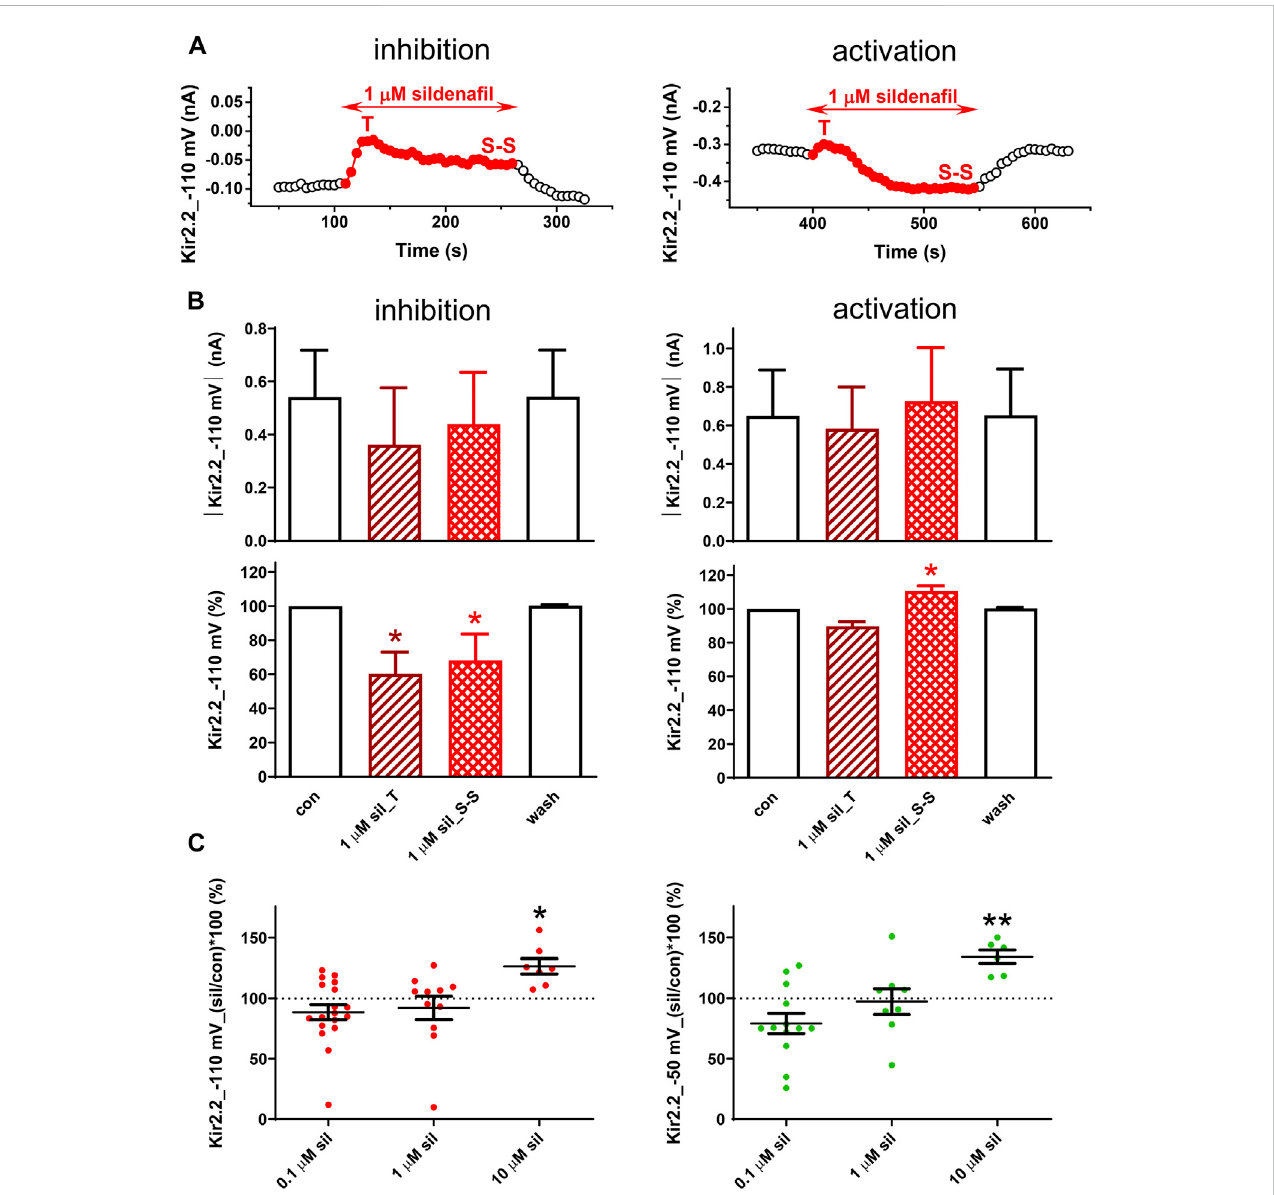
FIGURE 3 Effect of sildena fi l on the human Kir2.2 channels. (A) Representative time courses of Kir2.2 changes in control (con), during application of 1 µM sildena fi l (sil),andduring thesubsequent wash-out(wash);T — transient effect, S-S — steady-state effect. (B) Kir2.2current anditsaverage changesunder1 µMsildena fi l (inhibition — n =5;activation — n =6). (C) Concentrationdependenceofthesteady-stateeffectofsildena fi lonthehumanKir2.2( n =6 – 19);*and**-statistical signi fi cance at p < 0.05 and 0.01,